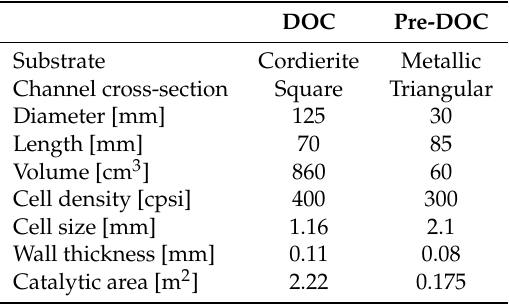
Table 3. Geometrical parameters of the oxidation